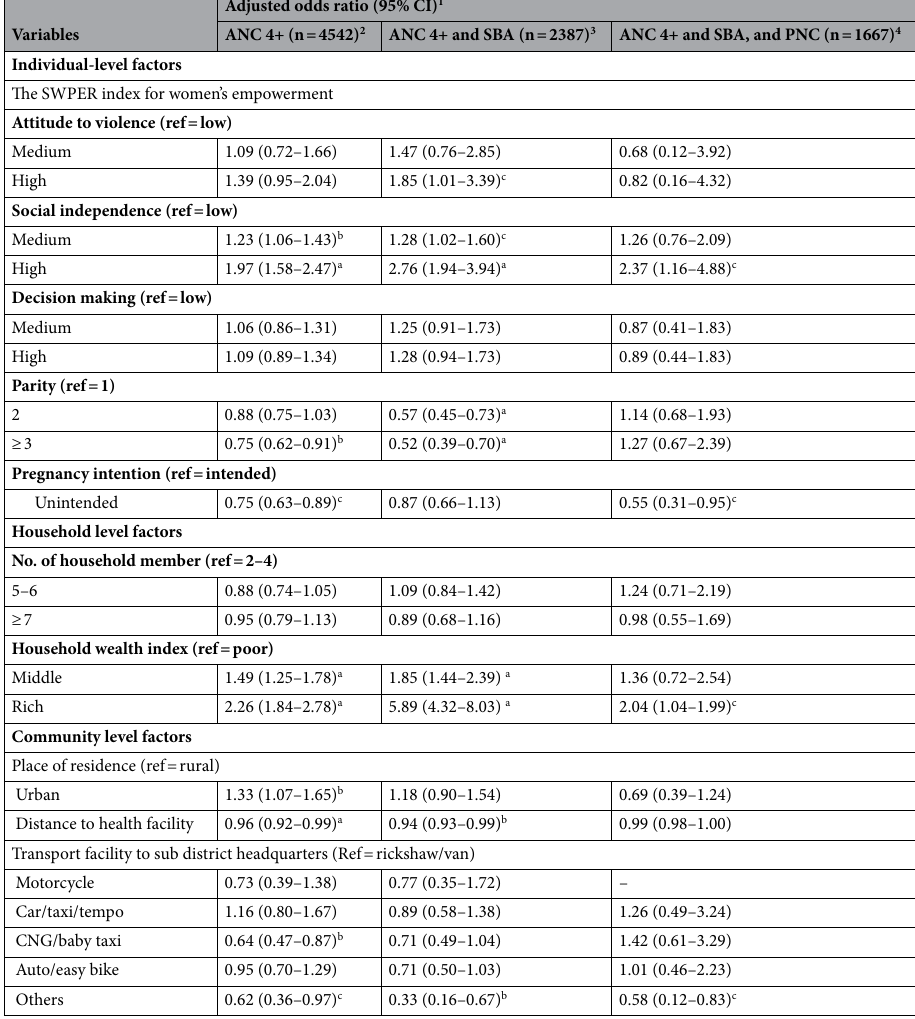
Table 4. Multilevel logistic regression analysis for the associations of CoC for maternal health with the dimensions of women’s empowerment along with other individual, household, and community-level factors: Bangladesh Demography and Health Survey 2017–2018. CI confidence interval. 1 Full model: adjusted for individual, household, and community-level factors. 2 Analyzed the predictors of four or more ANC visits by the sample of women who took at least one ANC. 3 Analyzed the factors associated with the CoC from pregnancy to having SBA among sample of women who received at least four ANC visits. 4 Estimates the effects of predictors on the CoC from delivery to early post-delivery period among sample of women who first received at least four ANC and SBA (i.e. completion of the entire CoC). Here a, b, & c indicates p < 0.001, p < 0.01, & p <